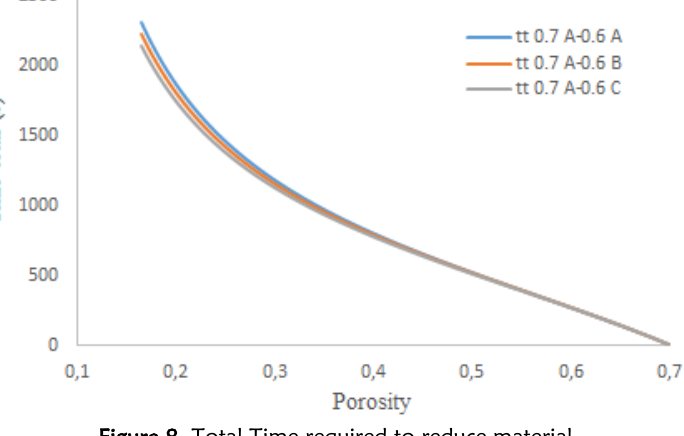
Figure 8. Total Time required to reduce